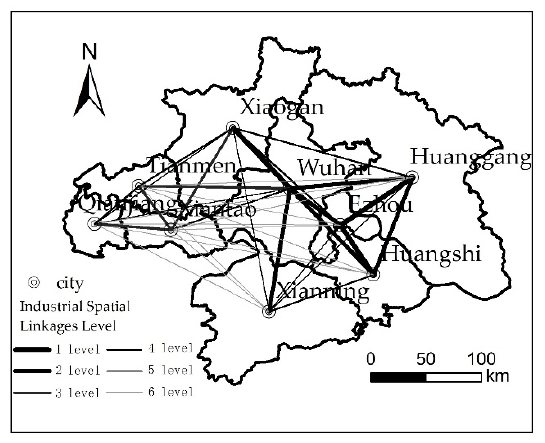
Figure 2. Industrial spatial linkages network of Wuhan urban agglomeration.The industrial spatial linkages are primarily theoretical references for the promotion of symbiotic development among regions and in the next step, the basis for calculating the comprehensive similarity among the industrial structures of the cities in the UA. The calculation results for industrial spatial linkages can provide a basis for not only the macro-industrial adjustment of UA but also for the optimization of industrial structure within each city.